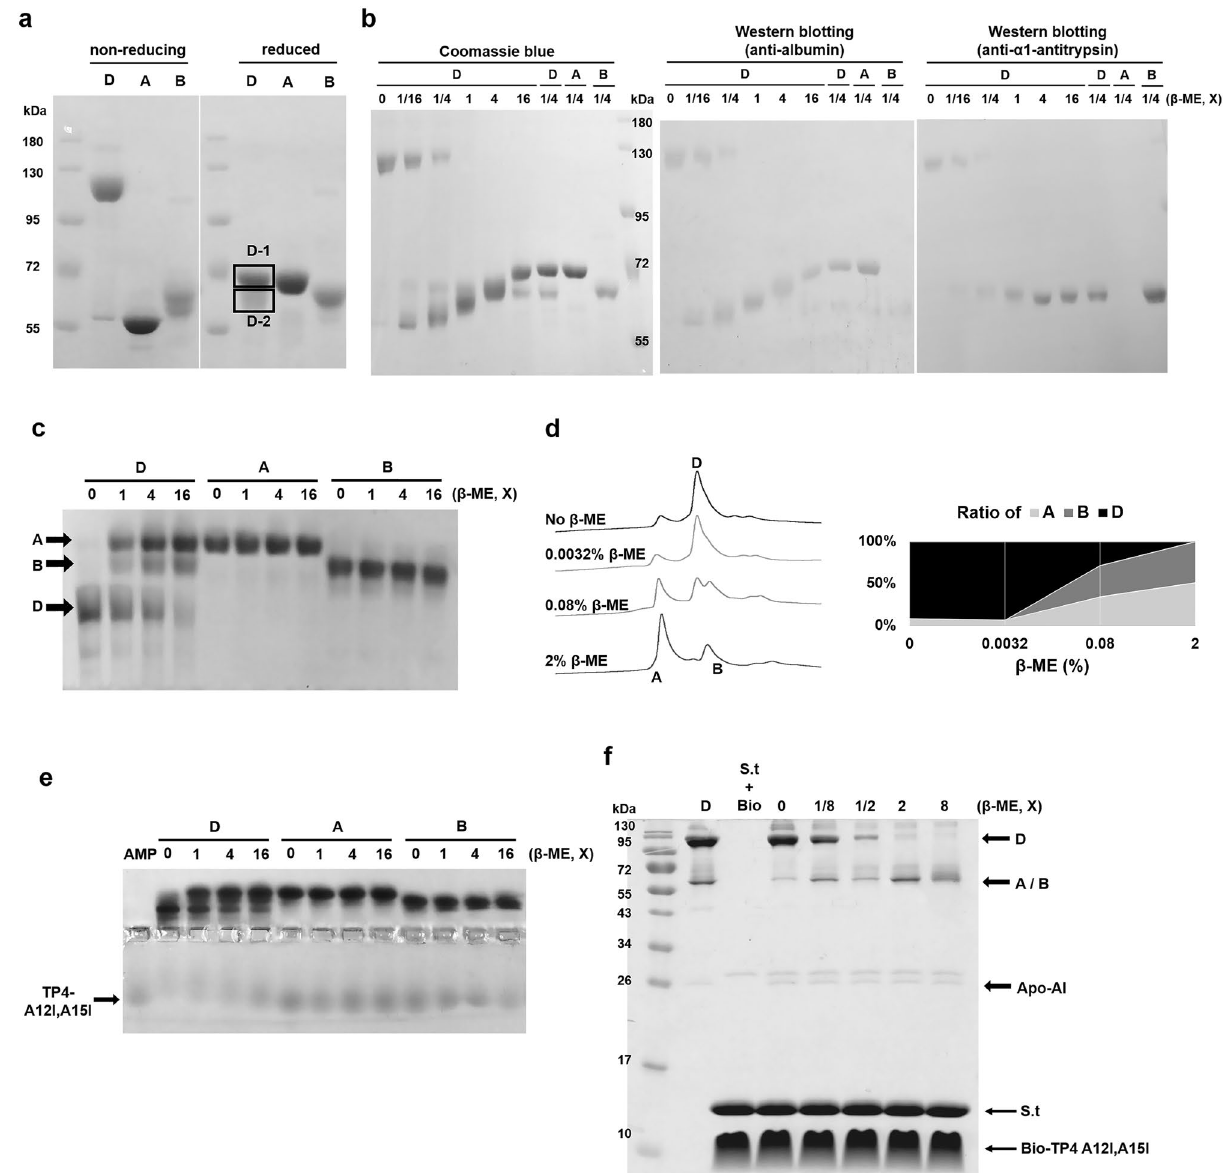
Figure 4. Protein D is composed of albumin and α1-antitrypsin linked by disulfide bond. ( a ) Protein D is dissociated into albumin and α1-antitrypsin by β-mercaptoethanol (β-ME). Proteins A, B and D (4 μg each) were analyzed by reduced (2.5% β-ME) (left) and non-reducing (right) 8% SDS-PAGE followed Coomassie blue staining. ( b ) Dissociation of protein D into protein A and B by increasing concentration of β-ME and analyzed by non-reducing SDS-PAGE (left) and Western blotting using antibodies raised against albumin (middle) and α1-antitrypsin (right). 1X represents 0.08% β-ME (v/v). ( c ) Dissociation of protein D into protein A and B by increasing concentration of β-ME and analyzed by 8% native PAGE, pH8.8. 1X represents 0.05% β-ME (v/v). ( d ) Separation of protein A and B from protein D by HPLC in the presence of β-ME. The elution profile of these dissociated proteins by HPLC (left) and the quantification of individual protein (right) were shown. ( e , f ) Decrease of AMP-binding ability of protein D by β-ME. The binding ability of proteins D, A and B to TP4-A12I,A15I peptide were determined by band shift and pulling down assays after reduction with β-ME. 1X represents 0.05% β-ME. Bio, biotinylated